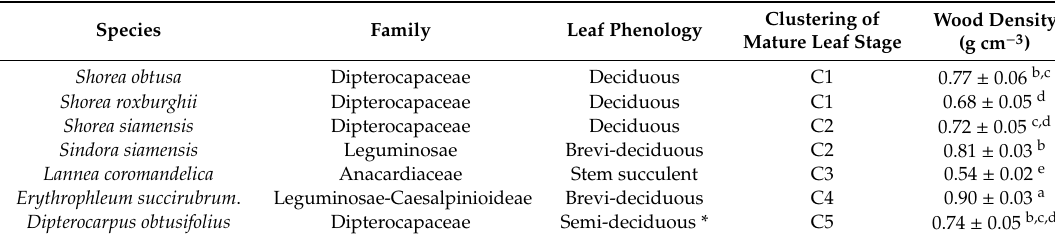
Table 1. Leaf phenological behavior and wood density ( ± standard variation of 8 samples) of seven species distributed in five clusters for mature leaf